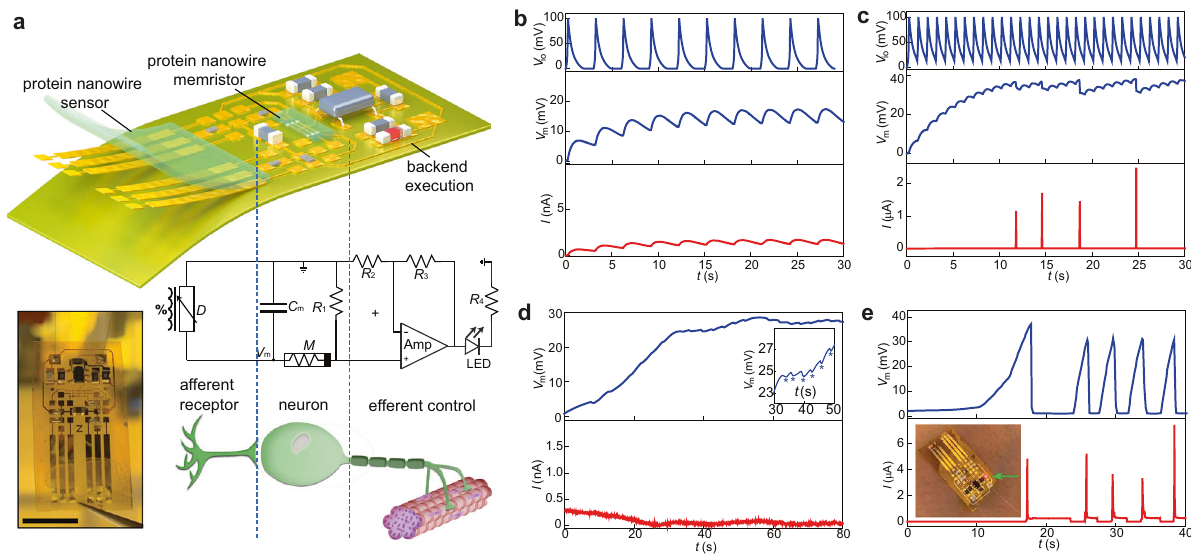
Fig. 3 Integrated wearable neuromorphic interface. a Schematic (top) and circuit diagram (middle) of a fabricated (left) integrated wearable interface. Scale bar, 1 cm. C m (10 µ F), R 1 / R 2 / R 3 / R 4 (20/1/100/1 k Ω ), and an Op Amp (LM321) were used in the circuit. b Simulated evolution in the membrane potential (middle panel) and current (bottom panel) from the arti fi cial neuron when receiving emulated normal (e.g., 0.3 Hz) respiratory sensing signal (top panel). c Simulated evolution in the membrane potential (middle panel) and current (bottom panel) from the arti fi cial neuron when receiving emulated abnormal (e.g., 1 Hz) respiratory sensing signal (top panel). d Measured membrane potential (top panel) and current (bottom panel) from the arti fi cial neuron with the sensor exposed to normal breathing. (Inset) The “ stars ” indicate discharging in membrane potential during breathing intervals. e Measured membrane potential (top panel) and current (bottom panel) from the arti fi cial neuron with the sensor exposed to abnormal breathing. (Inset) The lighting of the LED (0805URC) triggered by neuronal fi